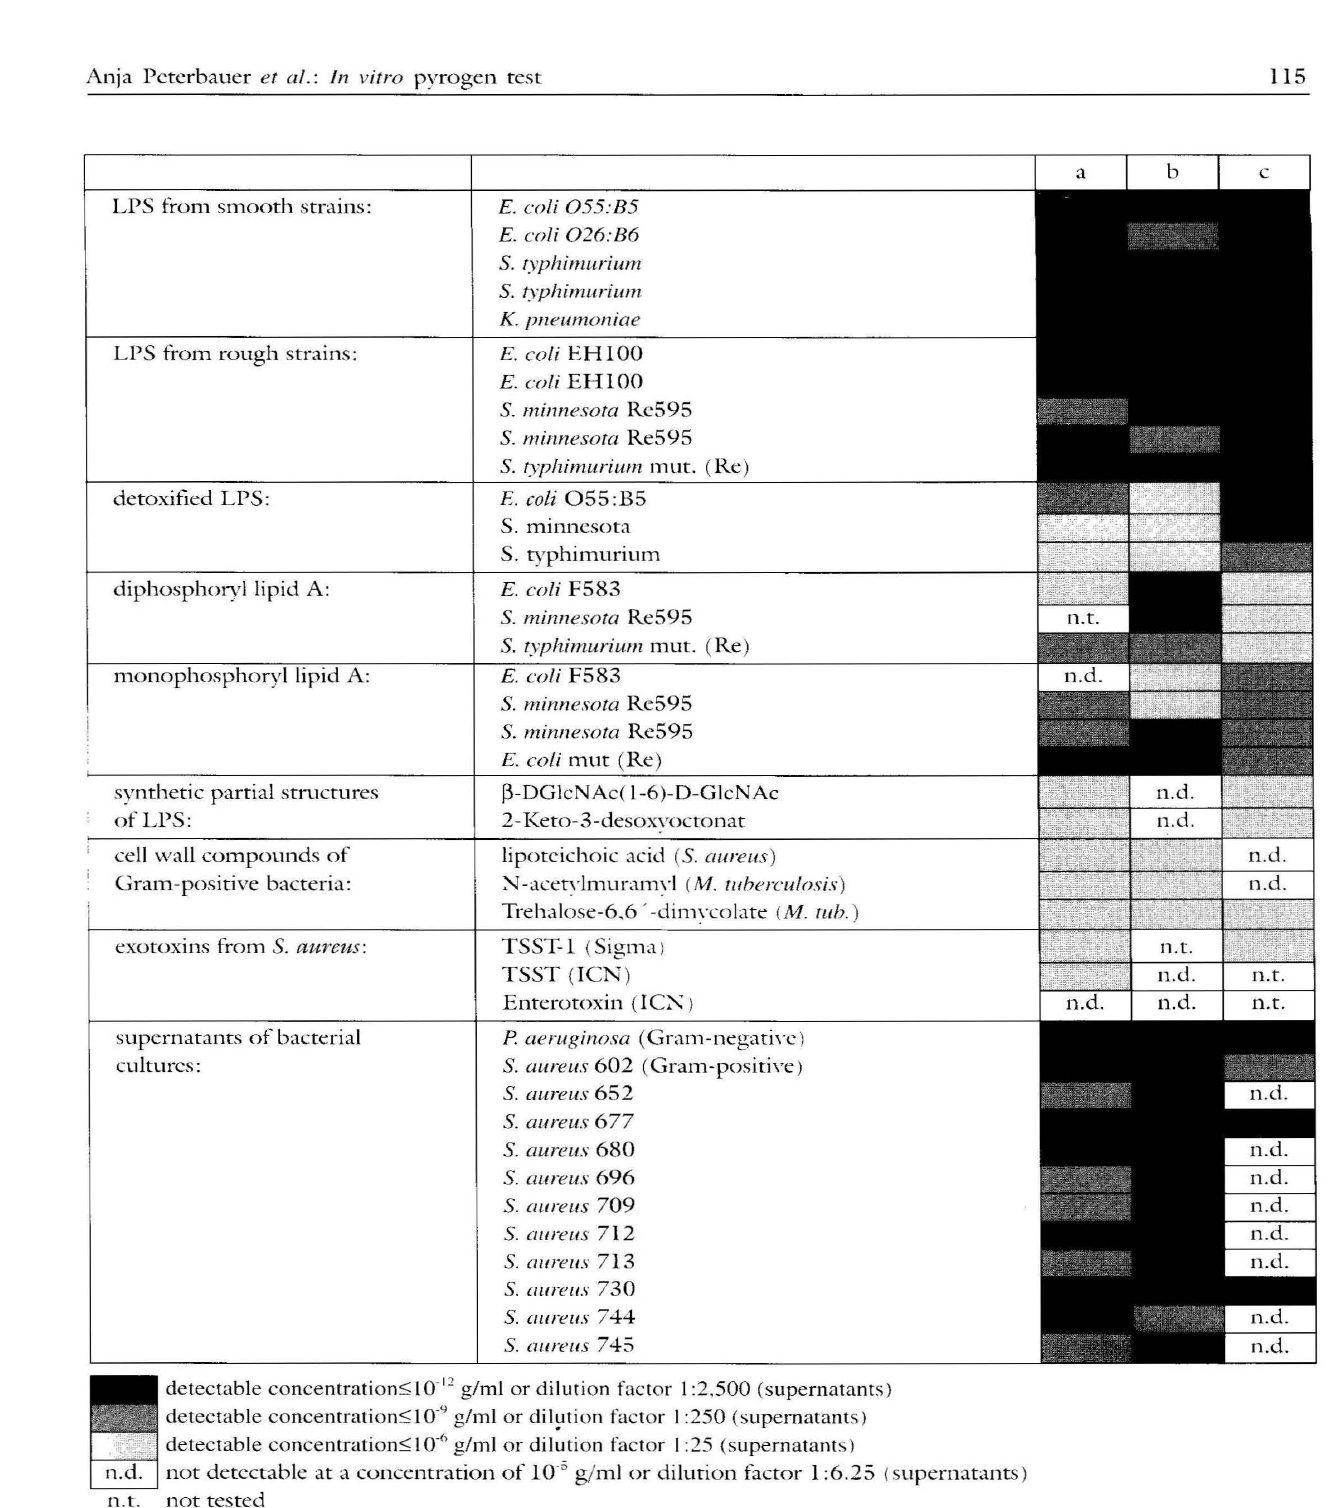
Figure 2. Comparison of the sensitivity of the cell lines THP-l grown in Ultraculmre and RAW264.7 grown in X-Vivo 20, both stimulated with 250 U lml IFN-y for 38 h, and a chromogenic LAL assay (QCL-IOOO fiom BioWhittaker).